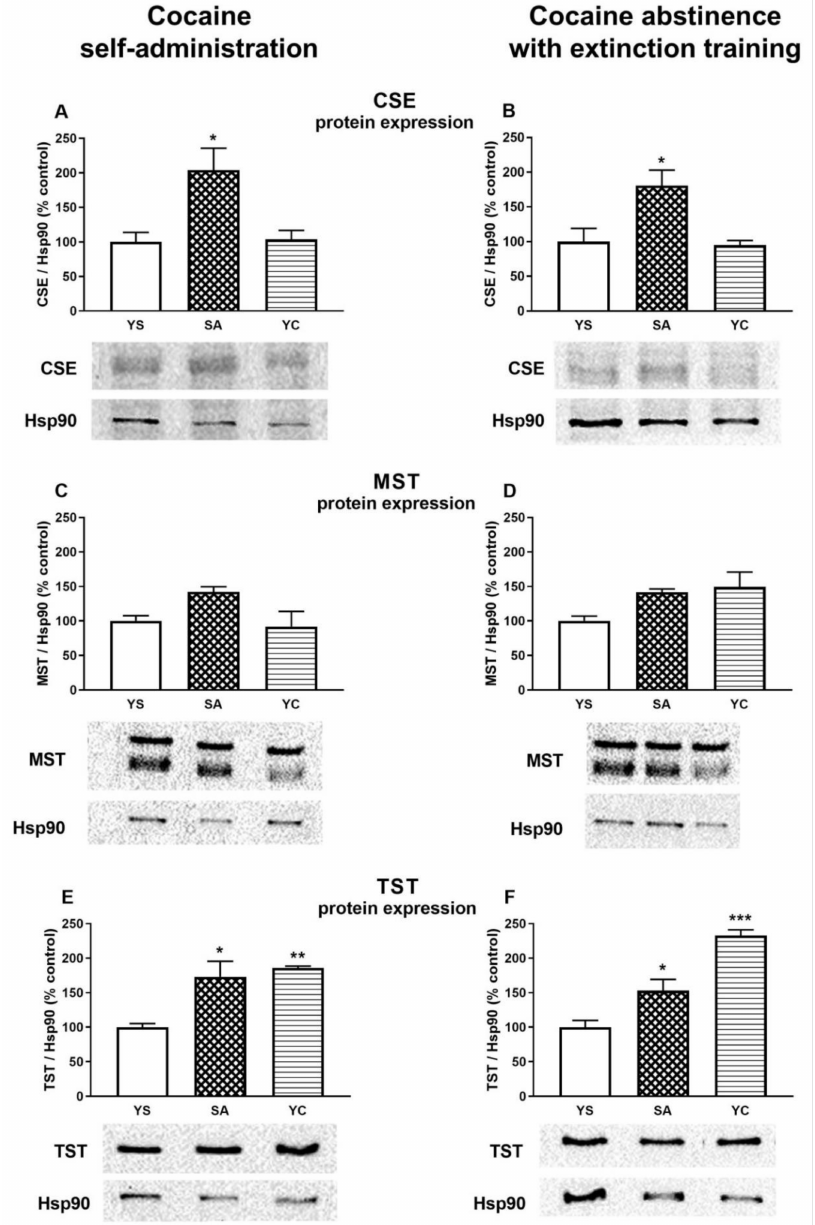
Figure 8. Western blot analysis of the CSE, MST, and TST protein expression in the presence of cocaine ( A , C , E ) and after 10 days of drug abstinence with extinction training ( B , D , F ) in the kidneys of rats self-administering cocaine (SA), receiving passive cocaine infusion (YC), and receiving saline infusions (YS): data are presented as the mean ± SEM, n = 3 rats per each group. * p < 0.05, ** p < 0.01, *** p < 0.001 vs. YS group. One representative band for the studied group (YS, SA, and YC) is shown under each